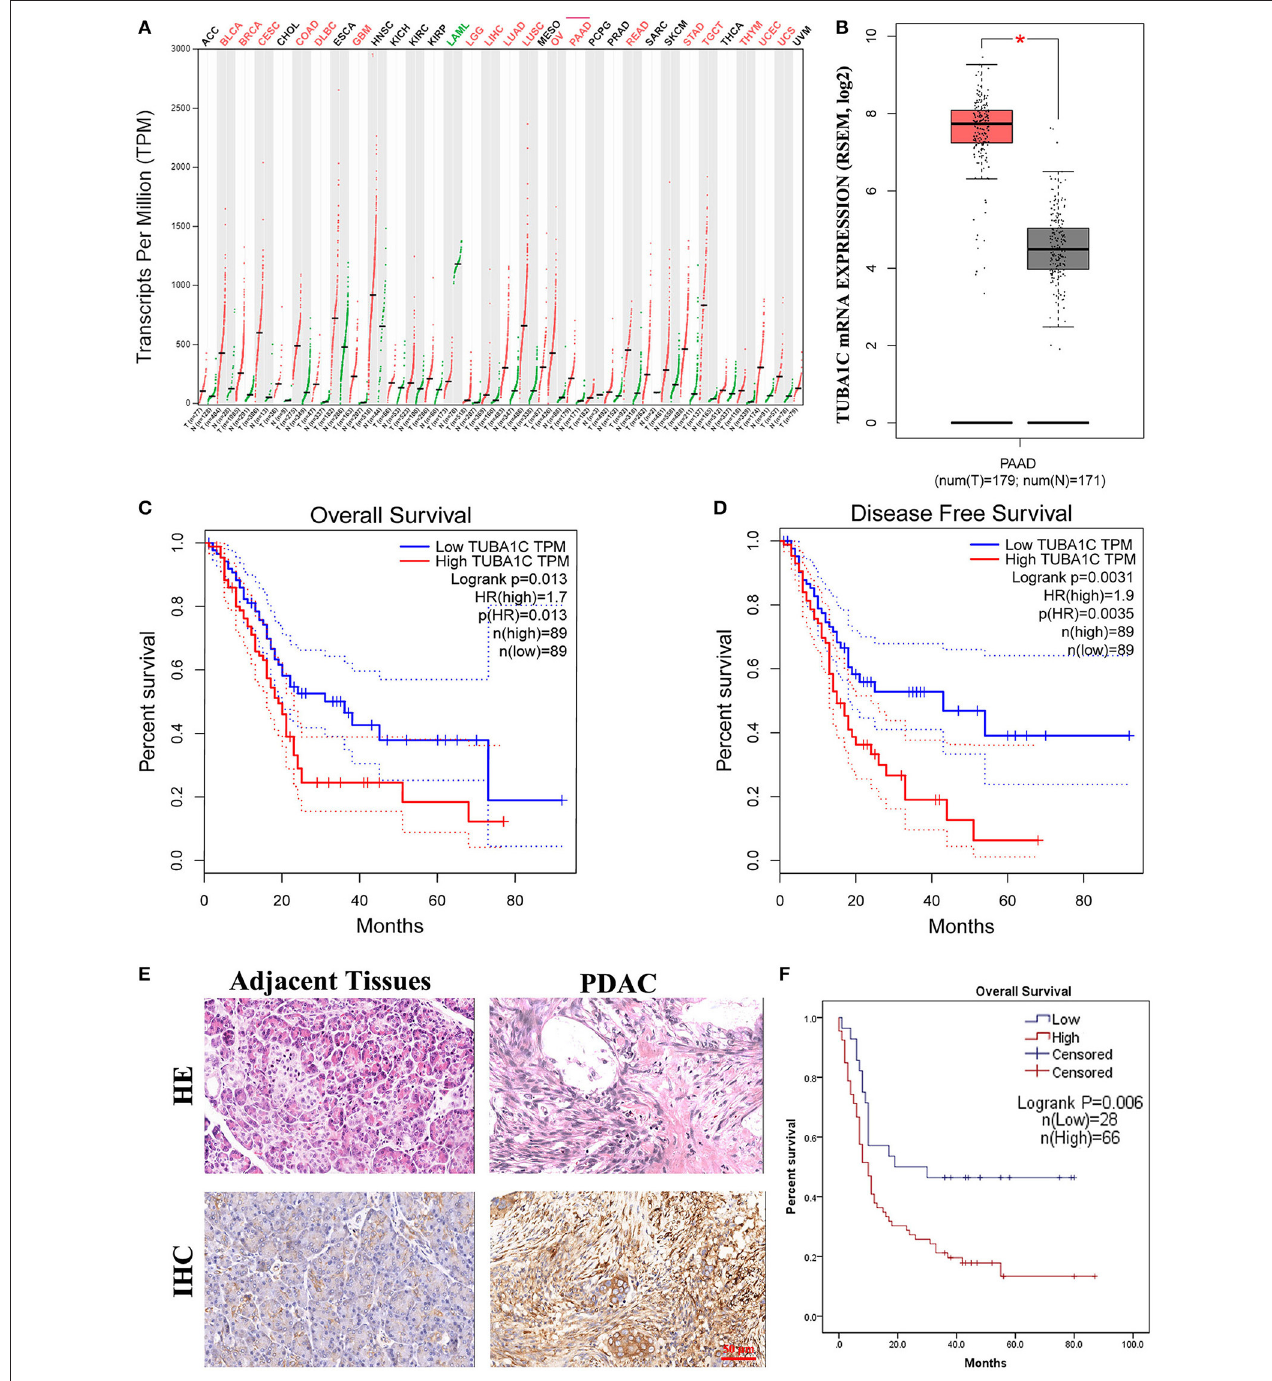
FIGURE 1 | The expression of TUBA1C in pancreatic ductal adenocarcinoma (PDAC) tissues. (A) TUBA1C mRNA expression levels in different tumor tissues obtained from the Gene Expression Profiling Interactive Analysis (GEPIA) database. The red dot and green dot represent the tumor sample and normal sample, respectively. A red label indicates that TUBA1C is upregulated in this cancer compared with its normal tissues, whereas the green denotes downregulation. A black label denotes that no significant difference was observed between tumor and normal tissue in this disease. (B) The expression level of TUBA1C was upregulated in PDAC ( n = 179) compared with normal tissues ( n = 171). (C,D) The overall survival and disease-free survival in high and low TUBA1C group were computed by GEPIA; high expression of TUBA1C correlated with poor prognosis of PDAC patients ( n = 178). Dashed line represents 95% confidence interval. (E) Representative HE and immunohistochemistry staining for PDAC tissues and adjacent pancreatic tissues. (F) Kaplan–Meier survival curves according to the expression level of TUBA1C in PDAC indicated that the high expression level of TUBA1C was significantly correlated with shorter overall survival ( n = 94; P = 0.006). Five cases could not be contacted, excluding survival